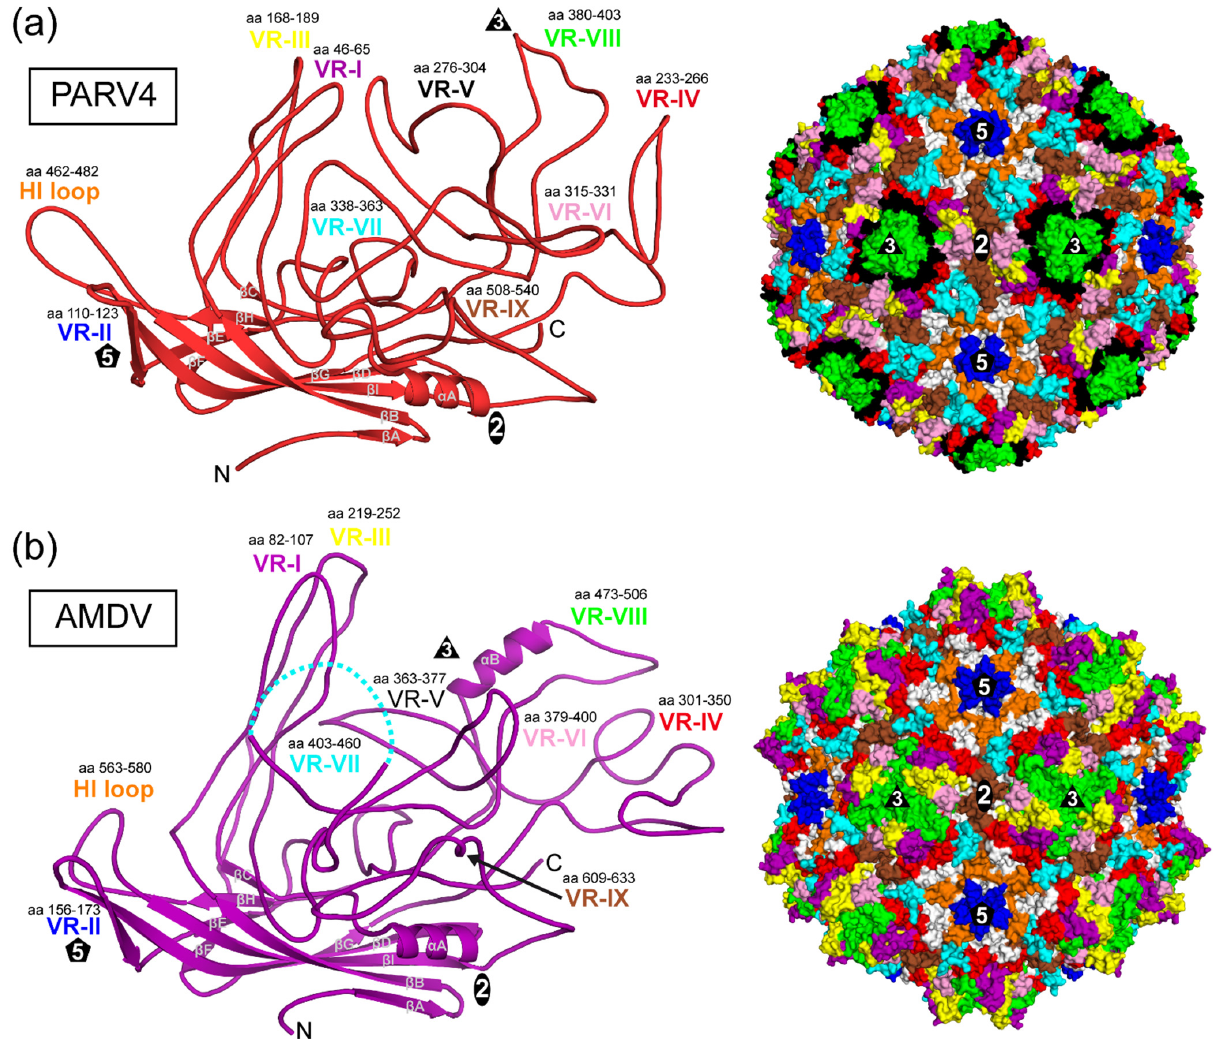
Figure 3. The PARV4 and AMDV VP structures. ( a ) Ribbon diagram (left) of PARV4 VP. The conserved β -barrel core motif ( β B– β I), β A, the α A helix, the N- and C-termini are indicated. The VRs (VR-I to -IX) are labeled and the approximate icosahedral two-, three-, and five-fold axes are represented by ovals, triangles, and pentagons, respectively. Right: The location of the VRs, colored as in the ribbon diagram, on the capsid surface of PARV4. ( b ) Ribbon diagram (left) and capsid surface map of AMDV VP, as in ( a ).